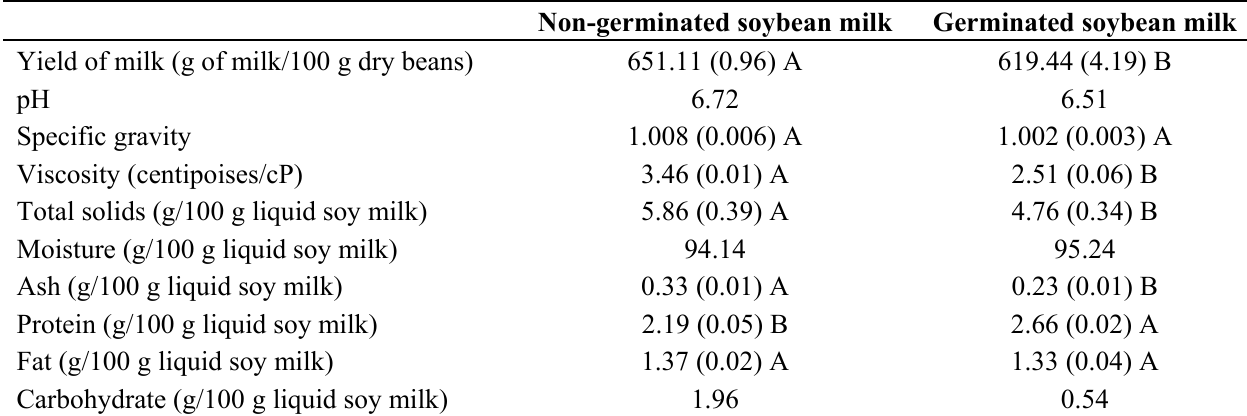
Table 2. Chemical and physical properties of soy milk made from non-germinated and germinated (28 h) soybean milk a